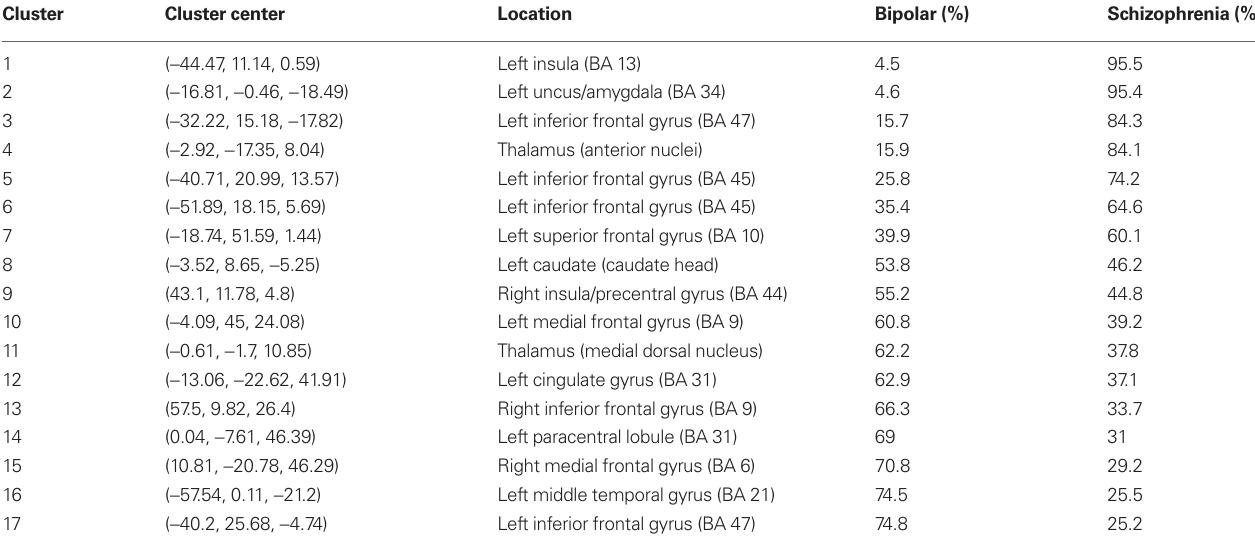
Table 2 | Percentage distribution of significant ALe clusters by disorder in reduced gray matter